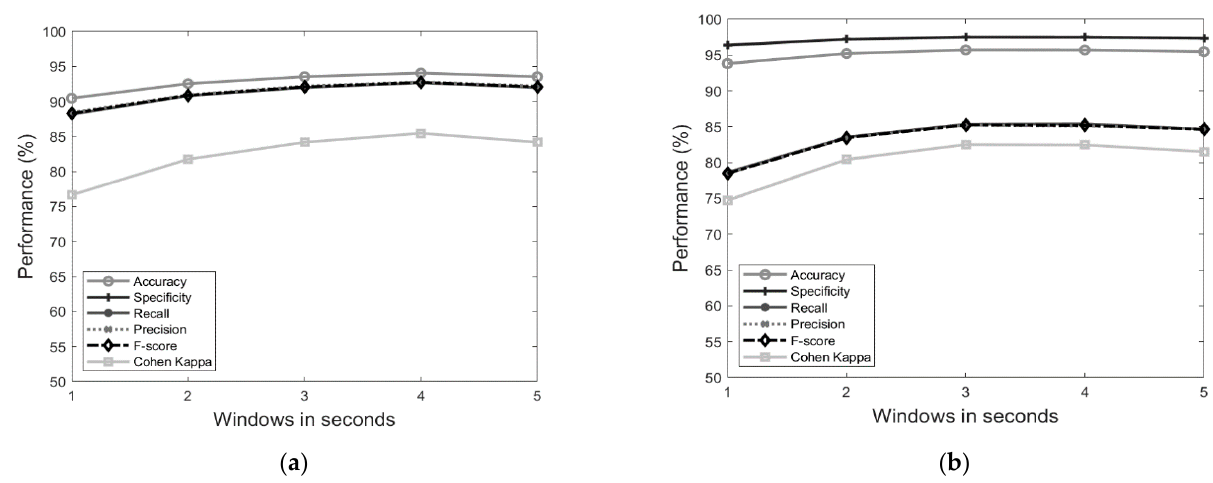
Figure 2. Performance (%) of the classifier for postures ( a ) and behaviours ( b ) as described in Table 1 across different window sizes (1–5 s). Metrics are computed as the mean of the postures/behaviours.